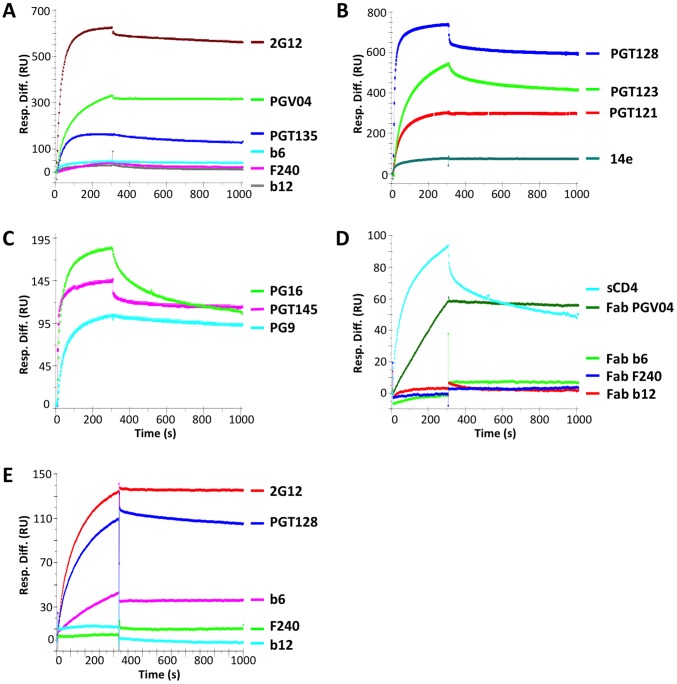
BG505 SOSIP.664 gp140 antigenicity by SPR.BG505 SOSIP.664-His gp140 trimers were immobilized on NTA chips (A–D). The sensorgrams show the response (RU) over time (s) using IgGs at 1,000 nM (150,000 ng/ml) (A–C) or Fabs at 500 nM (25,000 ng/ml) (D). The association phase was 300 s and dissociation was followed over 600 s. (A) 2G12 (high), PGT135 (intermediate), PGV04 (high), b6 (marginal), b12 (undetectable) and F240 (undetectable); (B) PG9, PG16, PGT145 (all intermediate); (C) PGT121 (intermediate), PGT123 (high), PGT128 (high), 14e (low); (D) Fabs of PGV04 (intermediate), b6, b12, and F240 (undetectable). (E) In an alternative approach, Env-reactive MAb was captured by anti-Fc Ab on the chip and the responses to BG505 SOSIP.664 gp140 trimers (200 nM; 78,000 ng/ml) were followed: 2G12 (high), PGT128 (high), b6 (low), b12, F240 (undetectable). Each curve represents one of 2–3 similar replicates.